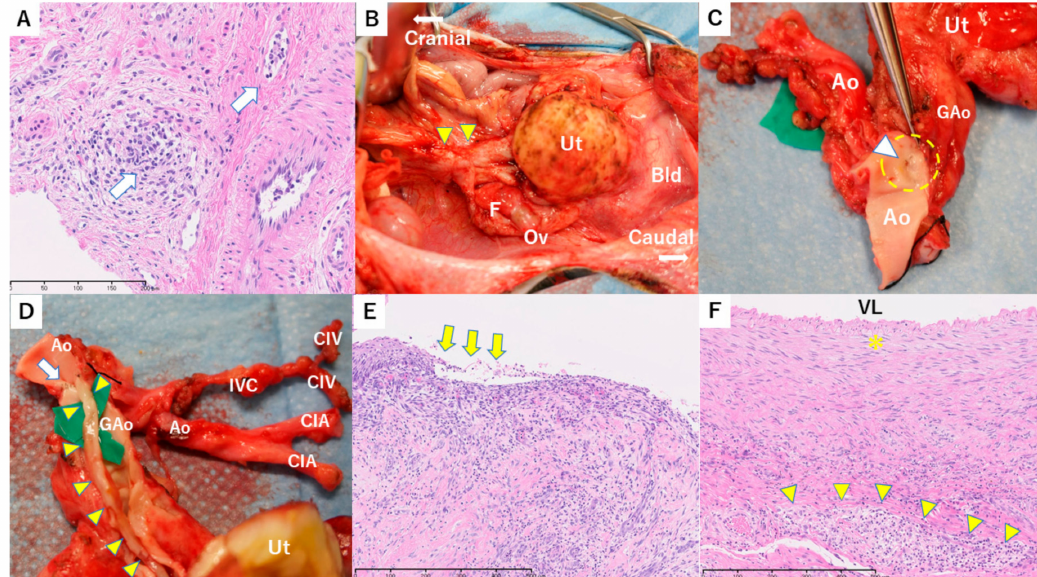
Figure 5. Macroscopic and histopathological findings in case 4. ( A ) Histopathological findings of a uterine tissue biopsy on POD 41. Perivascular lymphocyte infiltration and endotheliitis (white arrow) with perivascular fibrosis were clearly observed. Bar = 200 µ m. ( B ) Macroscopic findings of the abdomen in autopsy on POD 104, showing a whitish swollen transplanted uterus. Severe adhesion at a site surrounding vascular anastomosis was present (yellow angle). The right adnexa was detected, but the left ovary and oviduct were not detected due to severe adhesion. Ov, ovary; Ut, uterus; F, fimbria; Bld, bladder. ( C ) The site of vascular anastomosis between aortas of recipient and donor. The aorta of the recipient was dissected and observation of the anastomotic site (yellow circle) showed that almost all of the lumen of the grafted aorta of the donor was stenosed, resulting in a pin hole (white triangle). Ao, aorta; GAo, grafted aorta; Ut, uterus. ( D ) Removed grafted (donor) and recipient vessels. The grafted aorta was along the long axis and intravascular thrombi were found from the anastomotic site (white arrow) to the grafted common iliac arteries (yellow triangles). Ao, aorta; Gao, grafted aorta; IVC, inferior vena cava; CIA, common iliac artery; CIV, common iliac vein; Ut, uterus. ( E ) Histopathological findings in the cervix of the removed uterus. Severe endotheliitis and epithelial desquamation (yellow arrows) were seen in the cervix. Bar = 500 µ m. ( F ) Histopathological findings of the removed grafted aorta. Lymphocytes did not attack the endothelium (*) of the aorta directly; however, its feeding vessels in the vascular adventitia showed severe endotheliitis and obstruction (yellow triangles). Bar = 500 µ m. VL, vascular